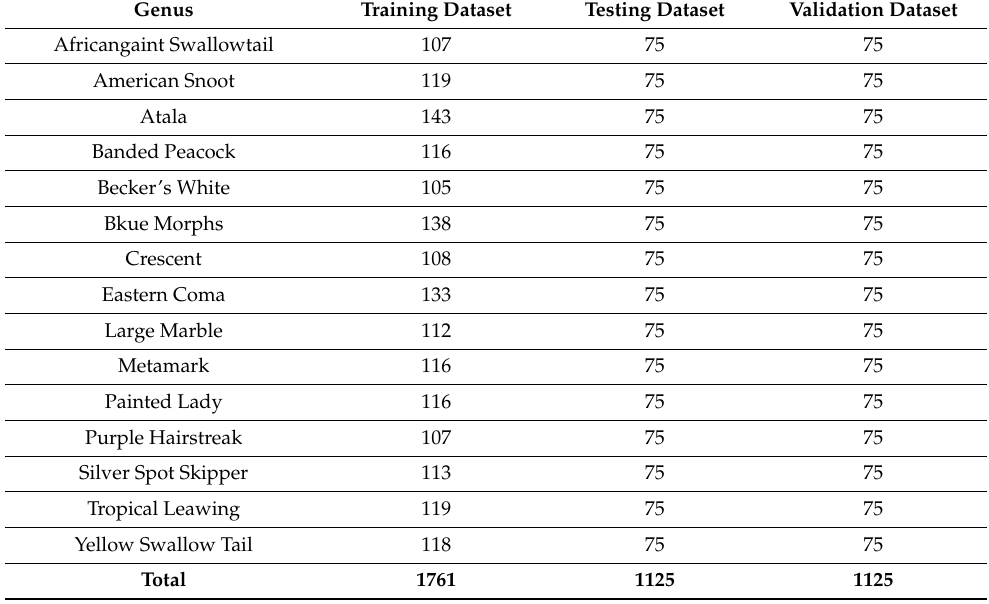
Table 1. Dataset